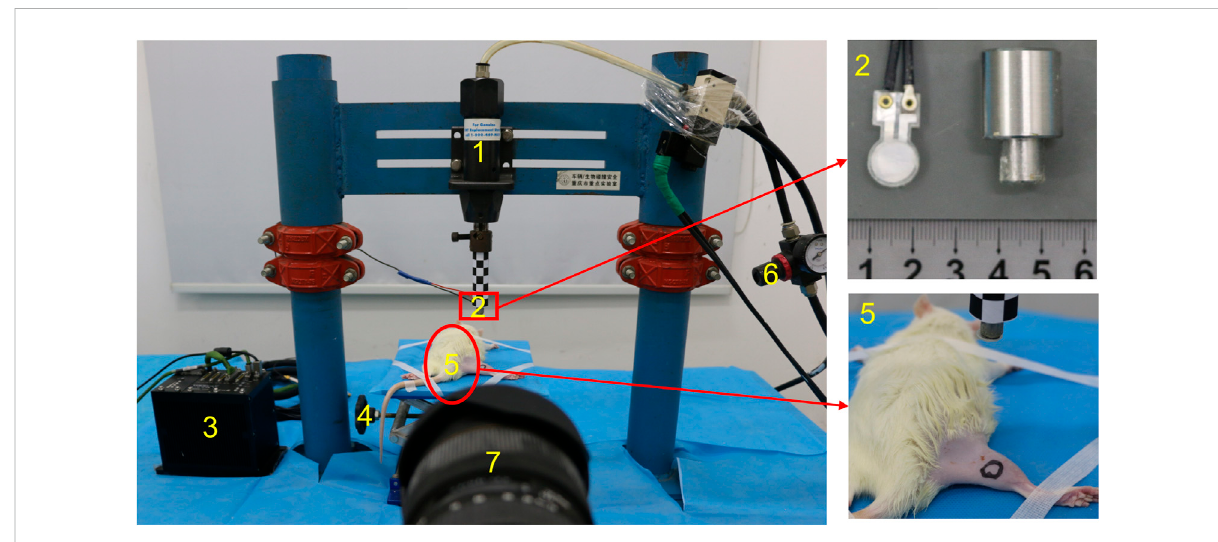
FIGURE 2 Photograph of the small pneumatic-driven bioimpact machine (1: cylinder, 2: impactor with a PVDF membrane pressure sensor, 3: signal test and analysis system, 4: 4-DOF adjustable frame, 5: rat, 6: air pressure regulating valve, and 7: high-speed